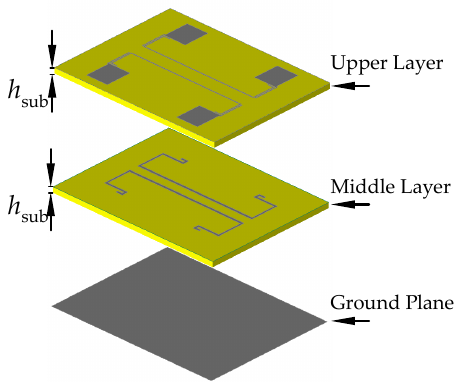
Figure 1. Deployed 3-D view of the proposed planar multilayer balanced dual-band bandpass filter.